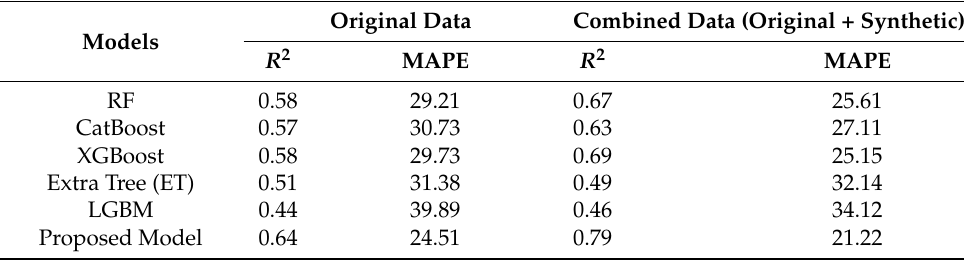
Table 3. Performance comparison with different single machine learning